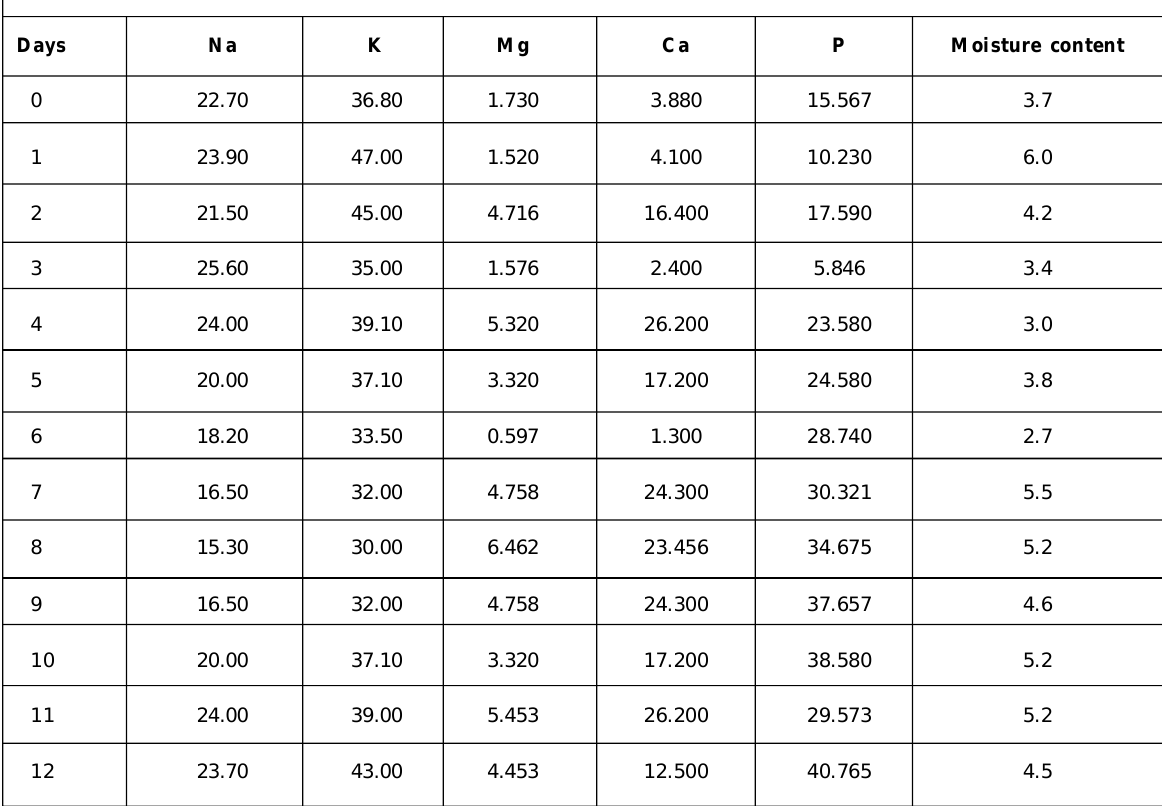
Table 6: Mineral estimation (ppm) of anaerobic fermented